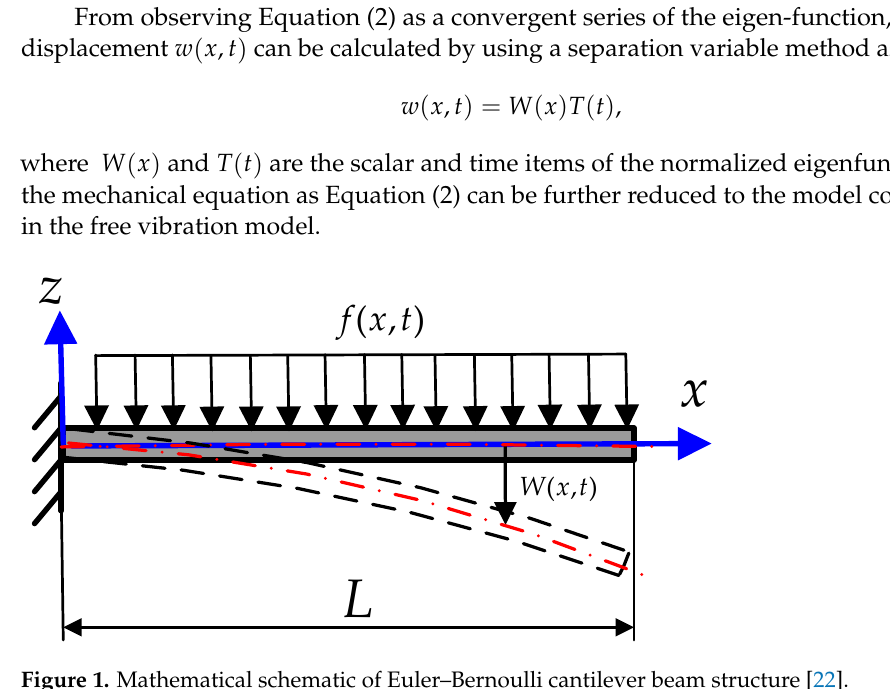
Figure 1. Mathematical schematic of Euler–Bernoulli cantilever beam structure [22].